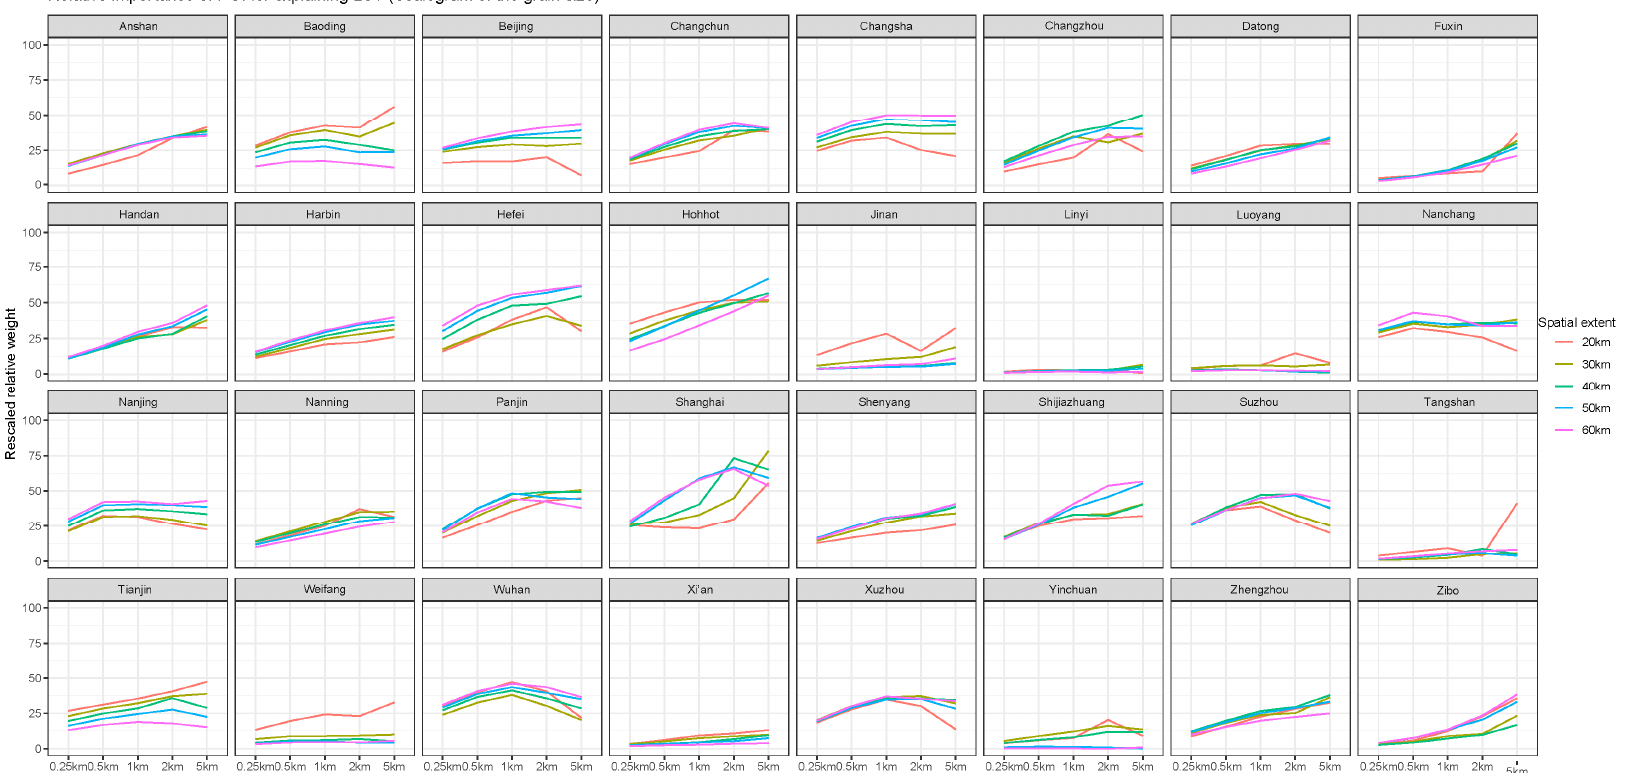
Figure A15. Relative importance of POI for explaning LST(Scalogram of the grain size).